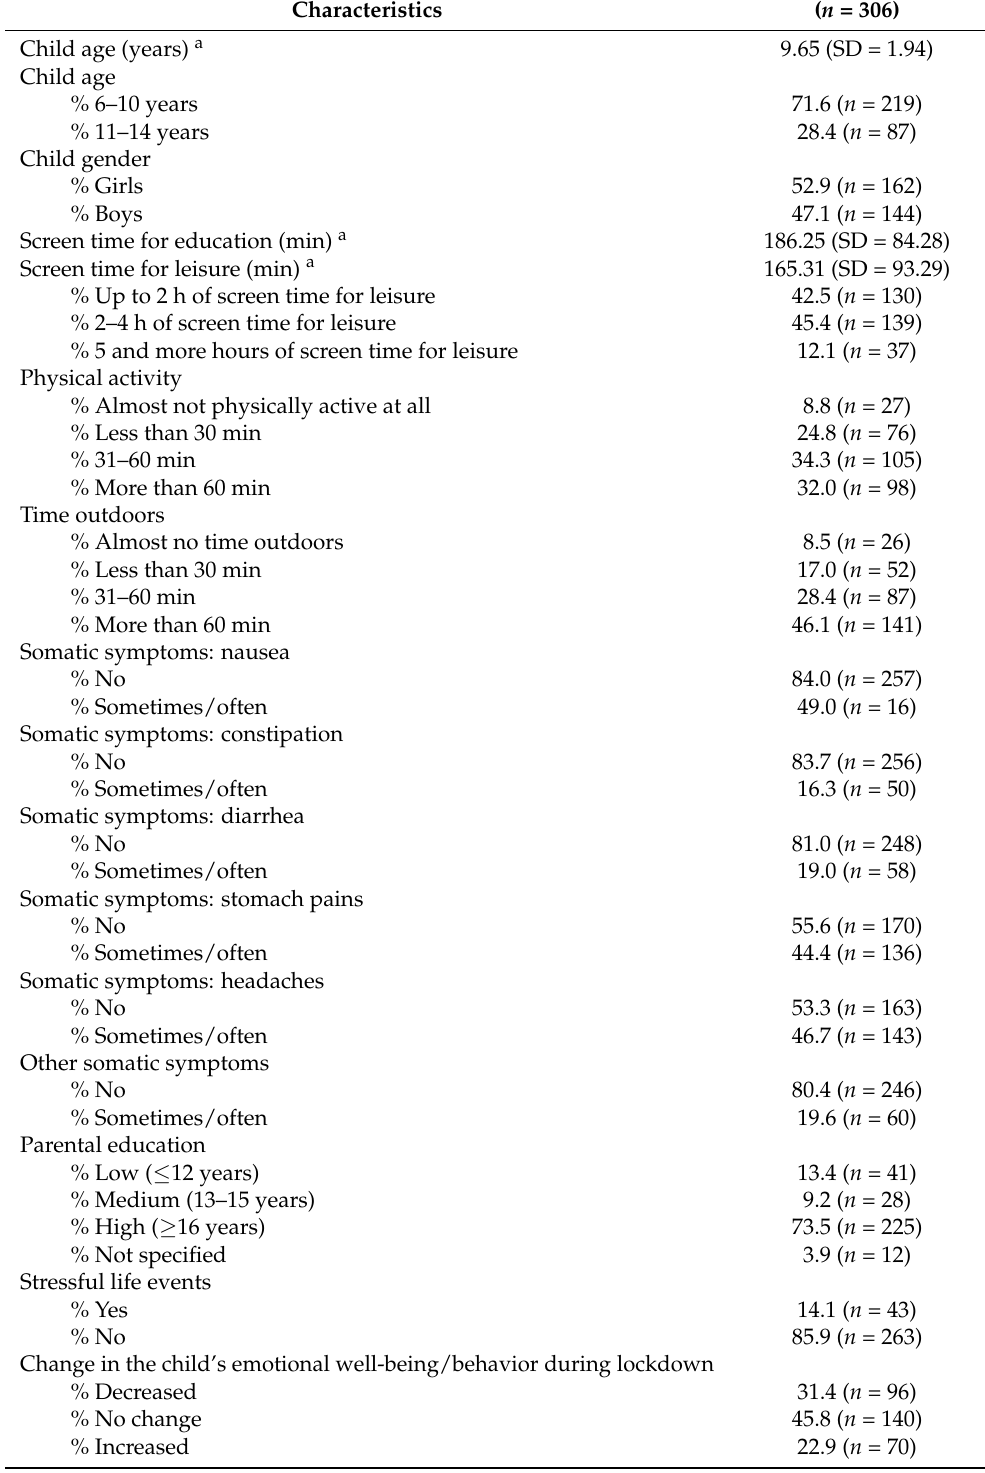
Table 1. Baseline characteristics of the